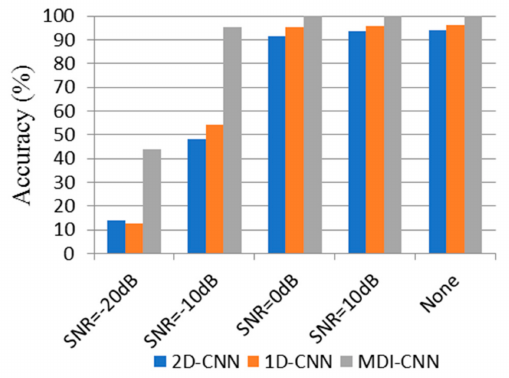
Figure 13. Testing diagnosis results of di ff erent models under di ff erent noise intensity.